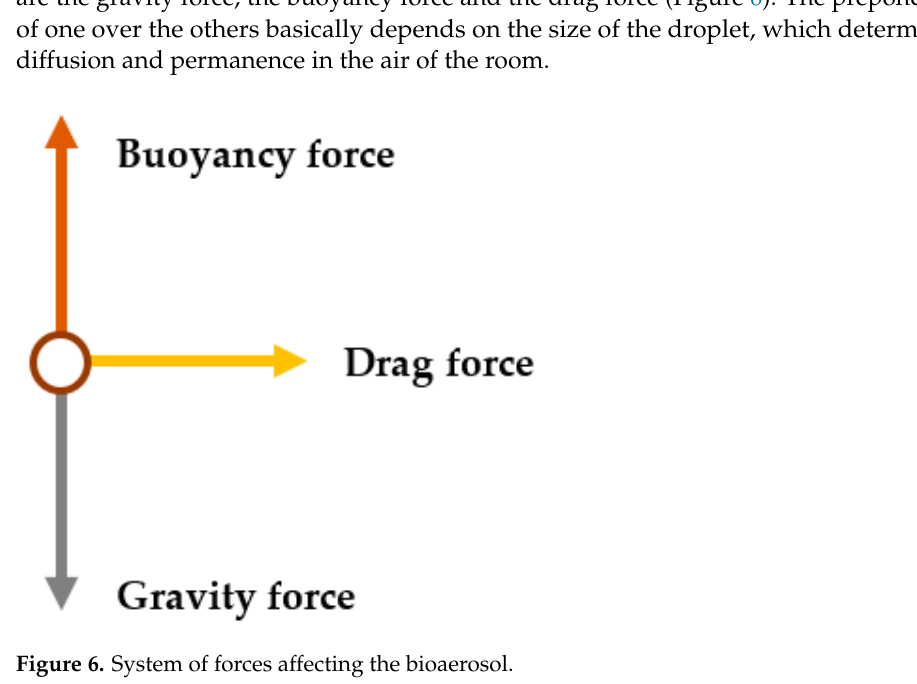
Figure 6. System of forces affecting the bioaerosol.